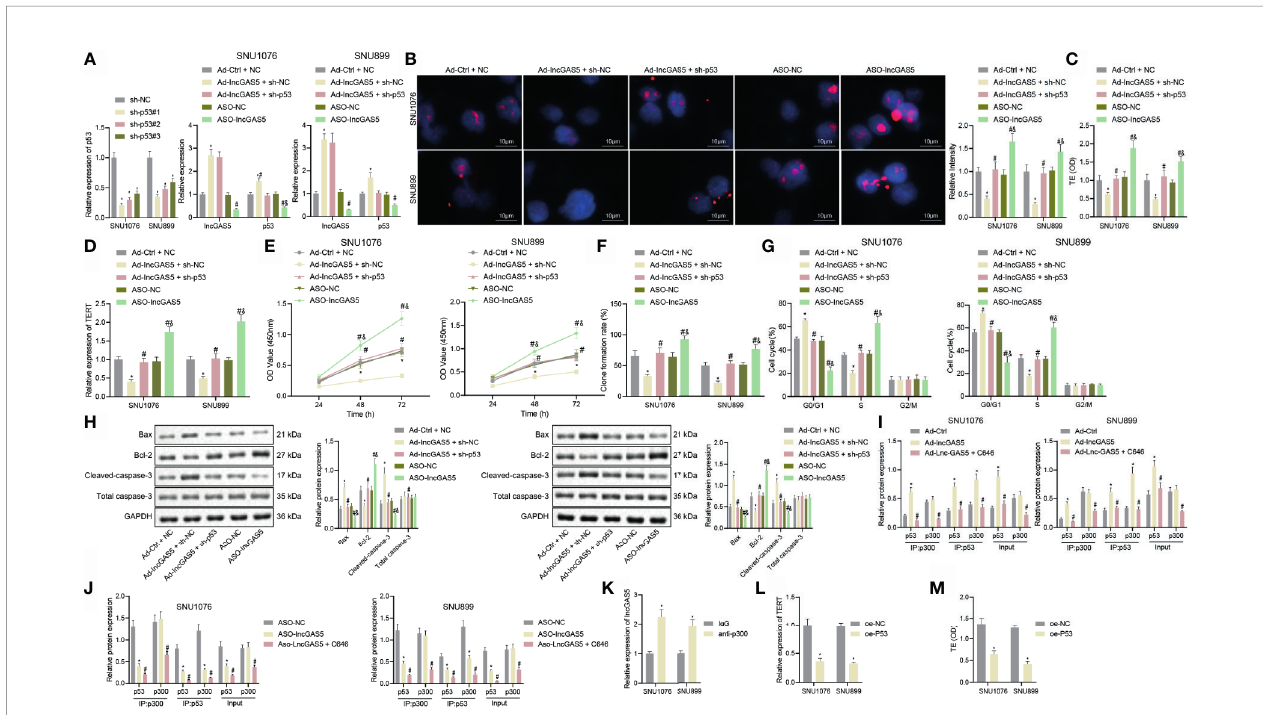
FIGURE 4 | GAS5 impairs telomerase activity and proliferation but promotes apoptosis of LSCC cells by stabilizing p53. (A) Knockdown ef fi ciency of p53 as well as p53 stability following GAS5 overexpression or silencing con fi rmed by RT-qPCR in SNU1076 and SNU899 cells, * indicates p < 0.05 compared with sh-NC/Ad-Ctrl + NC, # indicates p < 0.05 compared with Ad-GAS5 + sh-NC, and indicates p < 0.05 compared with ASO-NC. SNU1076 and SNU899 cells were transfected with GAS5, ASO-GAS5 or GAS5 + sh-p53. (B) Telomere length of cells measured by Q-FISH (the left). Blue indicates nucleus, and red indicates telomere, scale bar = 2 m m. mRNA expression of GAS5 and p53 stability in cells determined by RT-qPCR (the right). (C) Telomerase activity in cells detected by PCR-ELISA. (D) mRNA expression of TERT in cells determined by RT-qPCR. (E) Cell proliferation measured by CCK-8 assay. (F) Colony formation of cells measured by colony formation assay. (G) Cell cycle distribution measured by fl ow cytometry. (H) Western blot analysis of Bax, Bcl-2 and cleaved caspase-3 proteins in cells, normalized to GAPDH, * indicates p < 0.05 compared with Ad-Ctrl + NC, # indicates p < 0.05 compared with Ad-GAS5 + sh-NC, & indicates p < 0.05 compared with ASO- NC. (I, J) Protein expression of p300 and p53 stability in the immune complexes detected by Co-IP assay, * indicates p < 0.05 compared with Ad-Ctrl/ASO-NC, # indicates p < 0.05 compared with Ad-GAS5/ASO-GAS5. (K) Interaction between p300 and GAS5 detected by RIP assay, * indicates p < 0.05 compared with IgG. (L) TERT mRNA expression in cells following p53 overexpression detected by RT-qPCR. (M) Telomerase activity in cells following p53 overexpression detected by PCR-ELISA, * indicates p < 0.05 compared with oe-NC. Data are shown as mean ± standard deviation of three technical replicates. Data between two groups were compared by unpaired t -test while those among multiple groups were compared by one-way ANOVA with Tukey ’ s post-hoc tests. Bonferroni-corrected two-way ANOVA was applied for data comparison at varied time